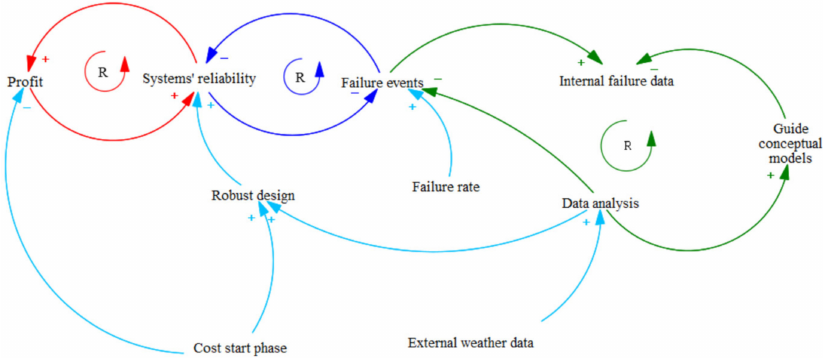
Figure 27. Casual loop: system’s